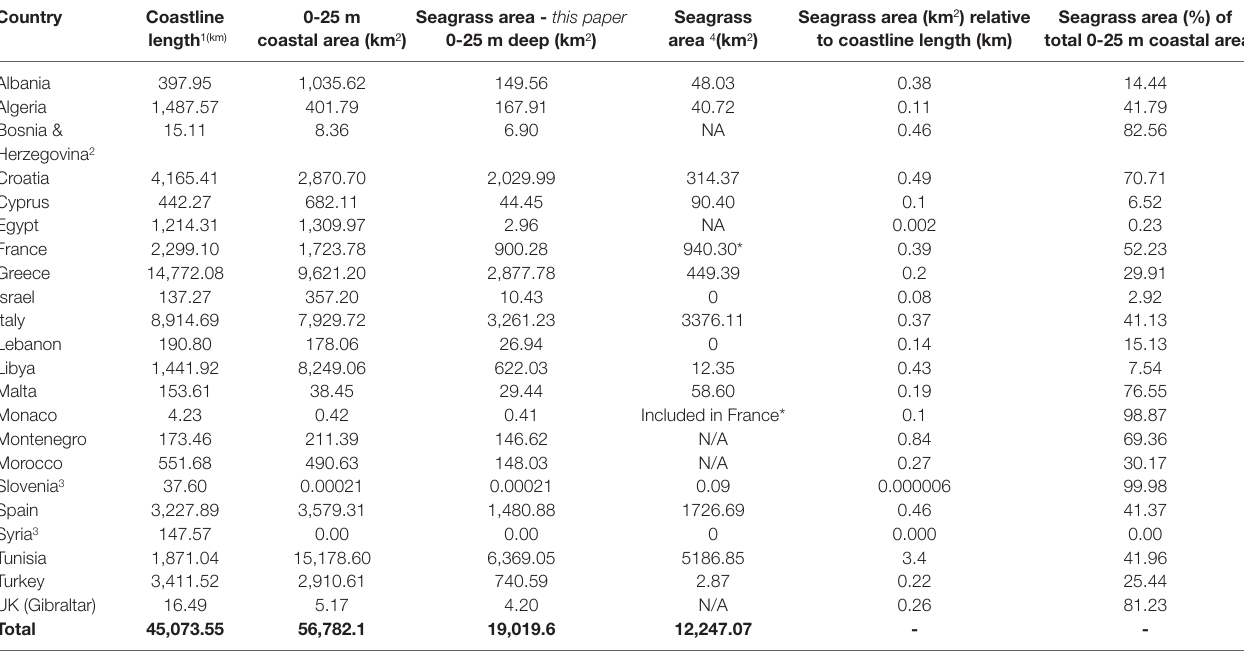
TABLE 3 | Country-scale P. oceanica seagrass mapping estimates (km 2 ) in the entire Mediterranean basin.